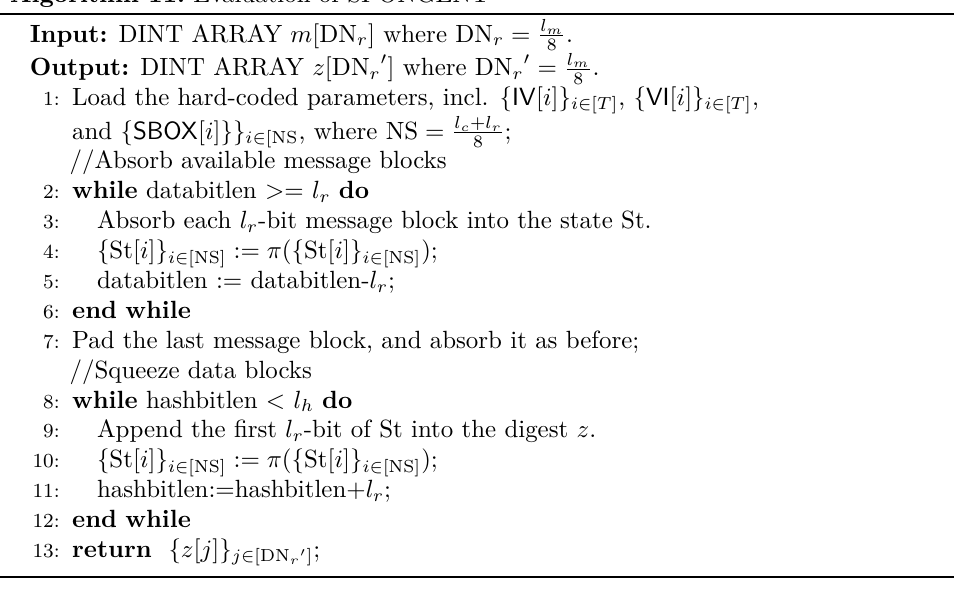
Algorithm 12: Permutation π s of